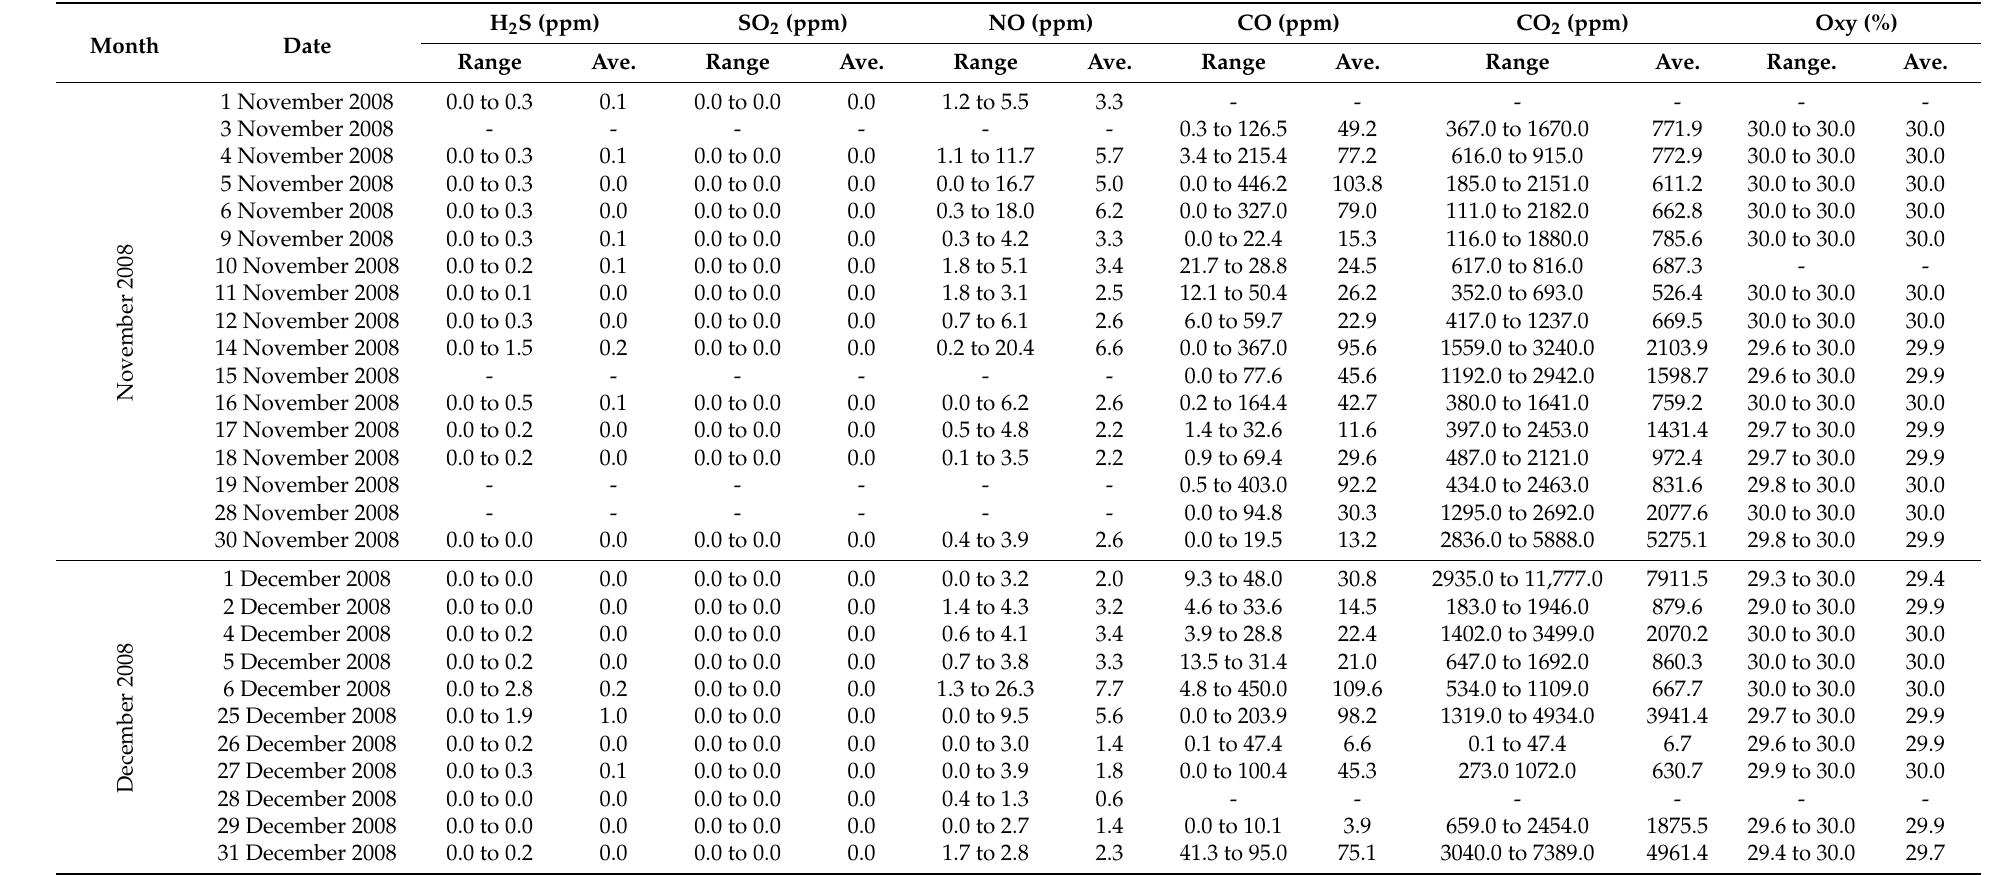
Table 1. Gas concentrations measured during the construction stage of Lowari Tunnel at selected